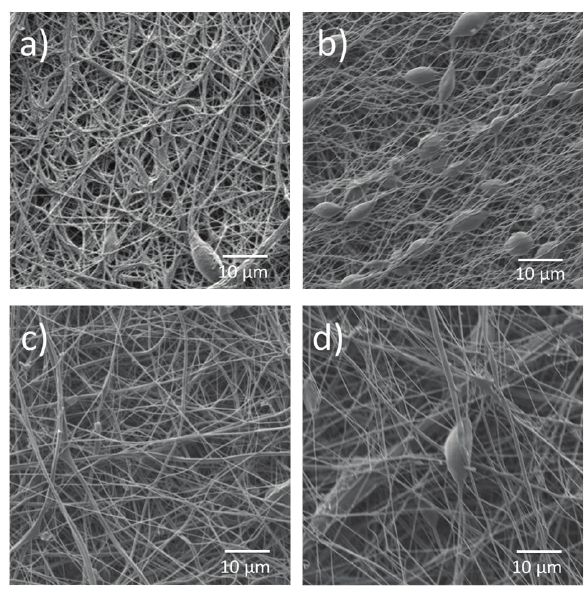
Fig. 1 – SEM micrographs of the PCL/silk fibroin scaffolds: a) PCL b) 10 % PCL/SF, c) 14 % PCL/SF and d) 18 %